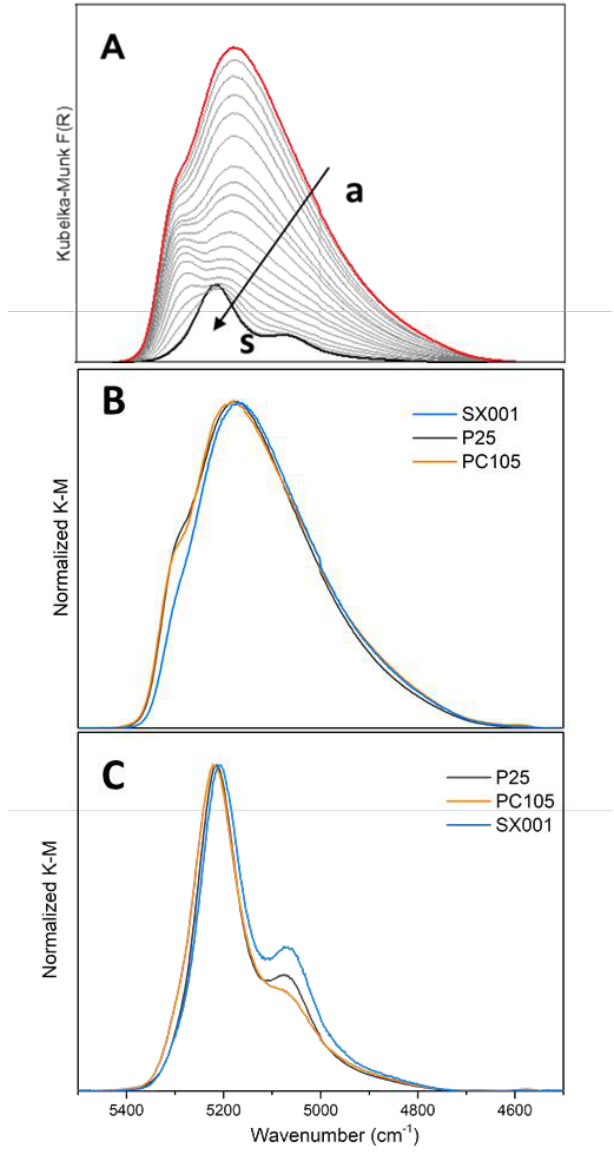
Figure 6. NIR spectra after activation at 873 K of ( A ) P25 in contact with H 2 O at 15 mbar (curve a) and progressive decreasing of the water coverage till outgassing H 2 O for 15 min at room temperature (curve s). ( B ) H 2 O adsorbed at 15 mbar on SX001 (light blue), P25 (dark grey) and PC105 (orange). ( C ) outgassing H 2 O for 15 min at room temperature for on SX001 (light blue), P25 (dark grey) and PC105 (orange). In part ( B ) and ( C ) the spectra have been normalized to the most intense peak.